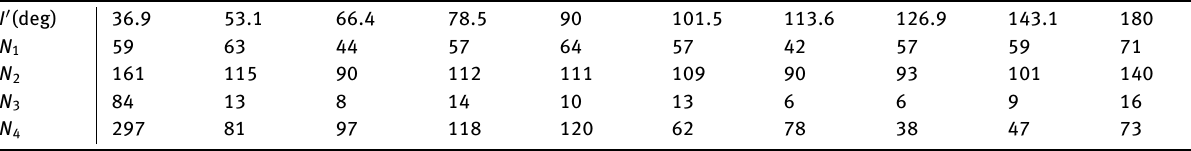
Table 1. Results of statistics of the parameter I ′ for split long-periodic and periodic comets in the case ∆ < 0.1 AU I ′ (deg)